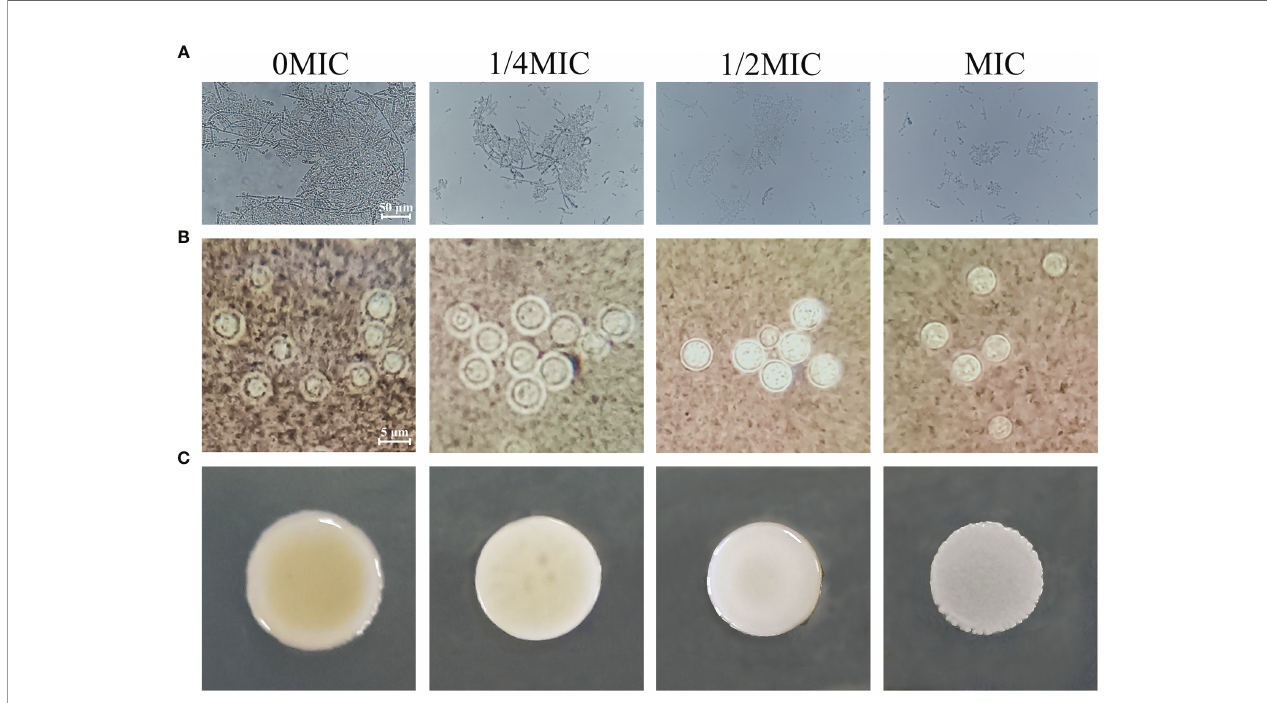
FIGURE 8 | Effects of paeonol on the hyphal development of C. albicans SC5314 (A) , as well as the capsule (B) and melanin (C) production of C. neoformans H99. (A) C. albicans SC5314 was cultured on hypha-inducing medium supplemented with different concentrations of paeonol and imaged using a fl uorescence-inverted microscope (scale bars, 50 m m). (B) India ink staining of the capsule of paeonol-treated C. neoformans H99. After C. neoformans H99 were treated with paeonol at 0, 1/4 MIC, 1/2 MIC, and MIC, the images were captured using the optical microscope (scale bars, 5 m m). The alterations of capsule thickness by paeonol-treated C. neoformans H99 were evaluated by measuring the capsule thickness of at least 30 cells. (C) Analysis of the melanin production of C. neoformans H99 exposed to paeonol. C. neoformans H99 was cultured on melanin-inducing medium supplemented with various concentrations of paeonol for 48 h at 30°C, and then examined.